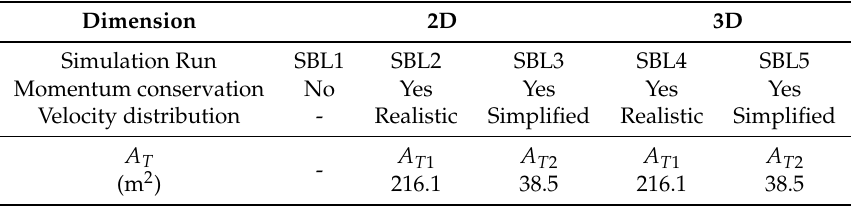
Table 2. Summary of the five different scenarios investigated in this study. Dimension 2D 3D Simulation Run SBL1 SBL2 SBL3 SBL4 SBL5 Momentum conservation No Yes Yes Yes Yes Velocity distribution - Realistic Simplified Realistic